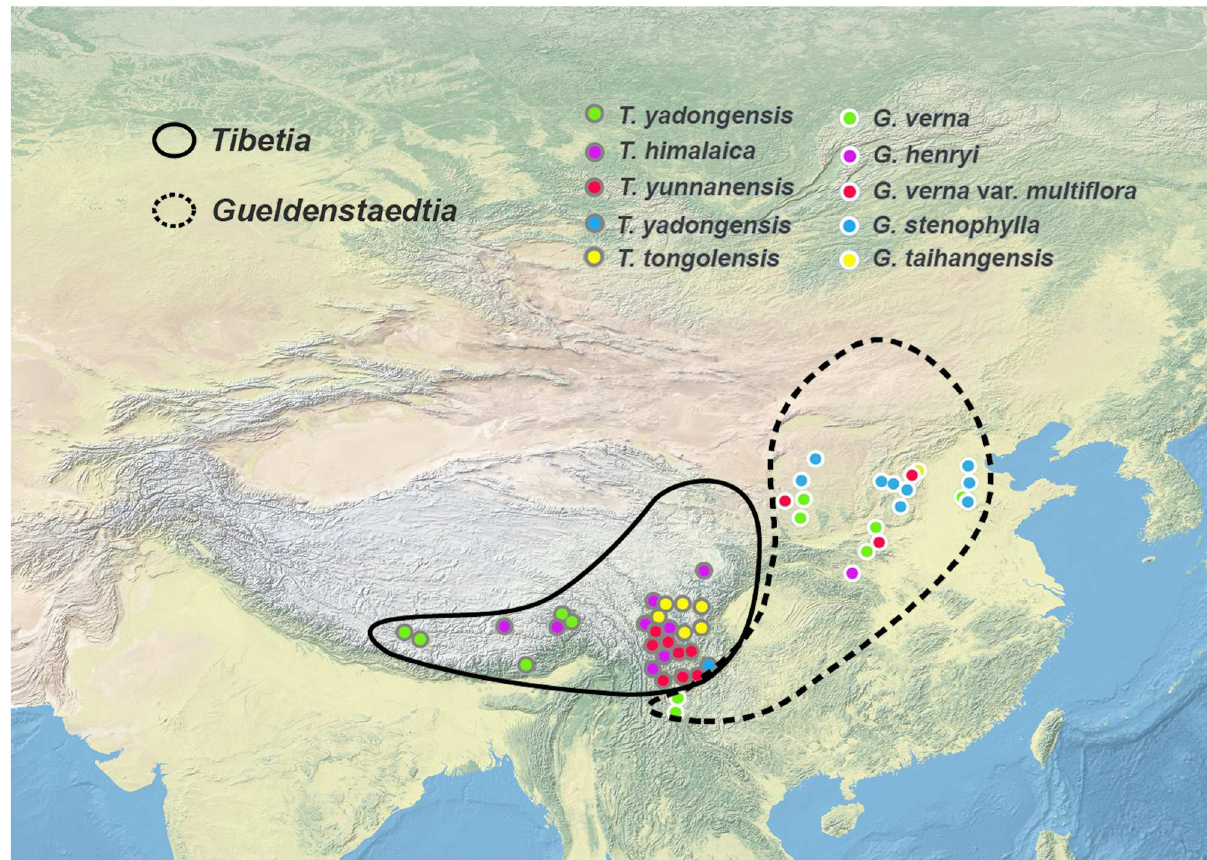
Fig 1. The distributionarea and sample sitesof Tibetia and Gueldenstaedtia in easternAsia. The map is fromthe website http://www.